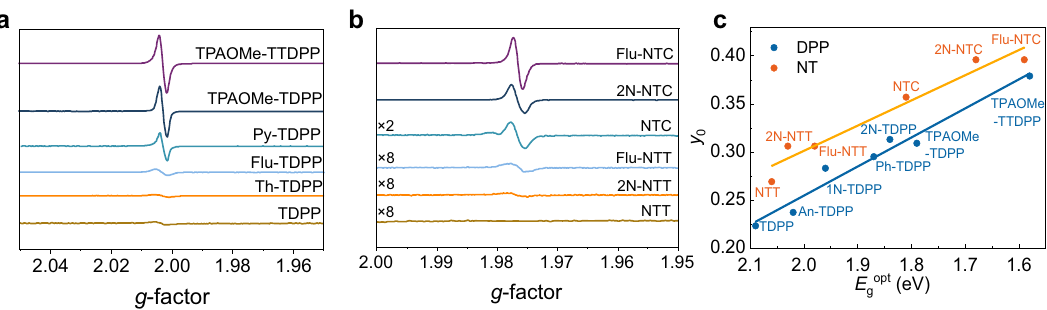
Fig. 3 ESR spectra of TDPP, NTC, and NTT derivatives and diradical index as a function of bandgap. a , b ESR spectra of powder samples comparing signal intensity using the same molar quantity of each material and under the same test conditions. c Calculated y 0 is plotted against experimental E g opt obtained from the thin- fi lm absorption pro Δ m = ± 2 transitions of all the compounds were not detected, s